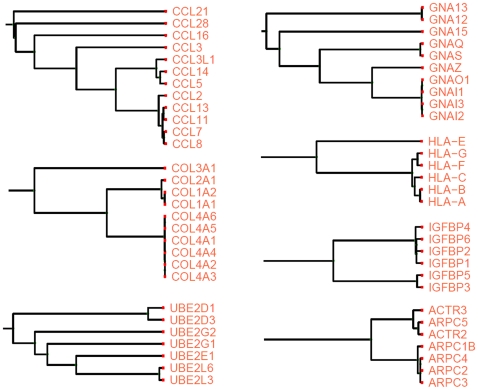
Examples of subclusters derived from the significant 4,233 protein associations.Apparently each of them belongs to the same functional module in which they perform similar or the same biological functions.